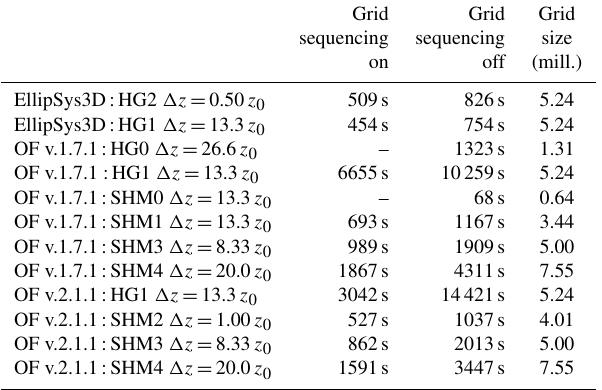
Table 3. Askervein Hill: simulation times for EllipSys3D and OpenFOAM codes. For information about different grids utilized in the computations, see Table 2 and Fig.